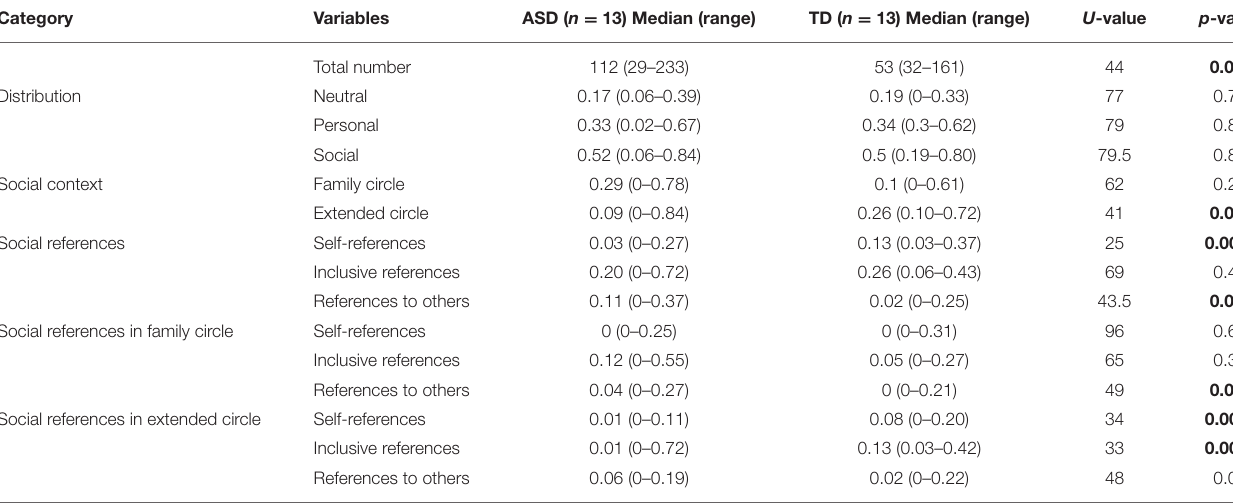
TABLE 2 | Median (Range) scores on social references, social context, and social positioning for participants’ narratives.